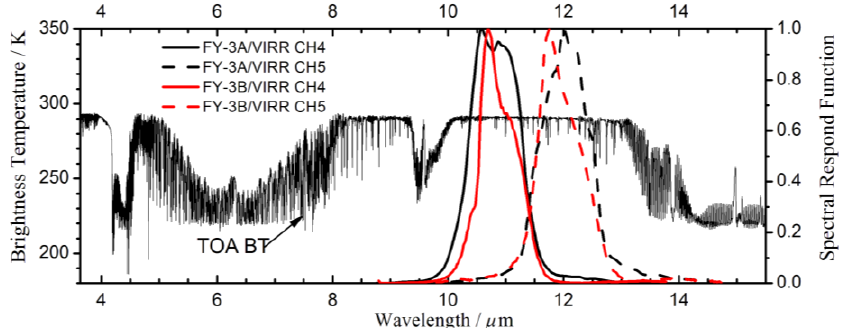
Figure 1. Normalized spectral response functions of FY-3A&B VIRR thermal infrared channels (CH4 and CH5), as well as the simulated top-of-atmosphere typical spectra of IASI over a clear sky. Solid lines denote SRFs of channel 4, and dashed lines denote that of channel 5. Black and red lines are for FY-3A and FY-3B,